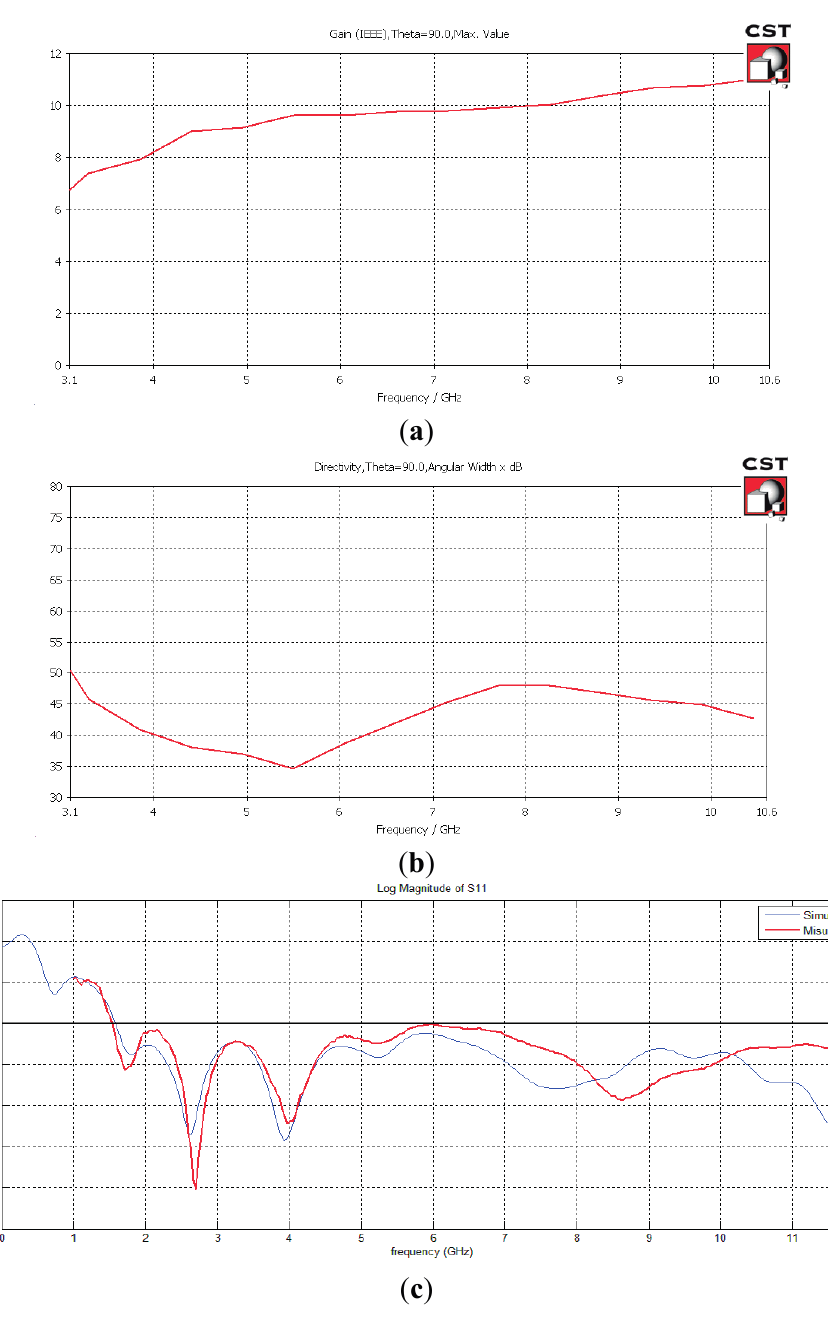
Figure 3. ( a ) Gain; ( b ) HPBW; ( c ) Comparison between the measured and the simulated S 11 of the designed Vivaldi